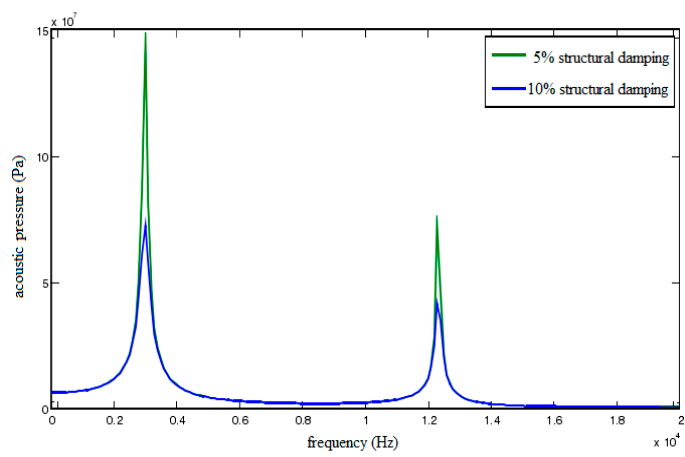
Figure 11. Acoustic pressure characteristic curves of field point A under different structural dampings.